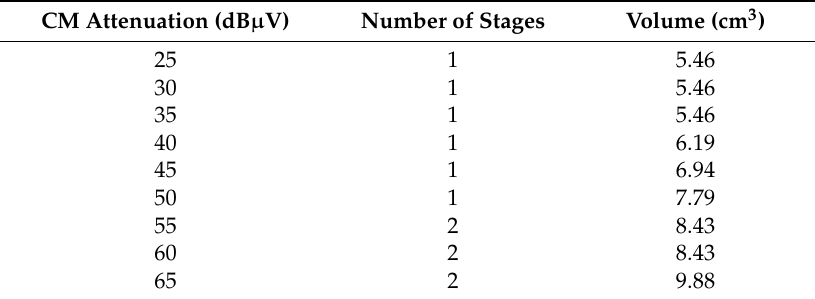
Volume and number of stages of the best design depending on the required CM attenuation–case study